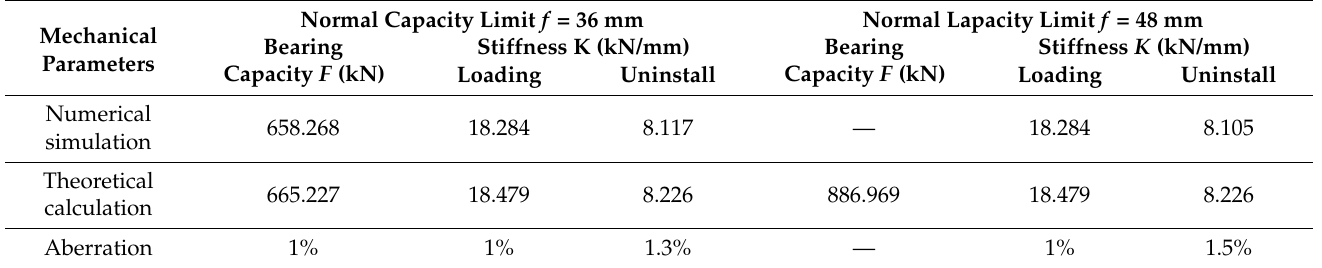
Figure 6. Comparison of load–displacement curves between theoretical calculation and numerical simulation for different capacity limits: ( a ) 36 mm; ( b ) 48 mm. Table 1. Comparative analysis of theoretical calculation and numerical simulation.